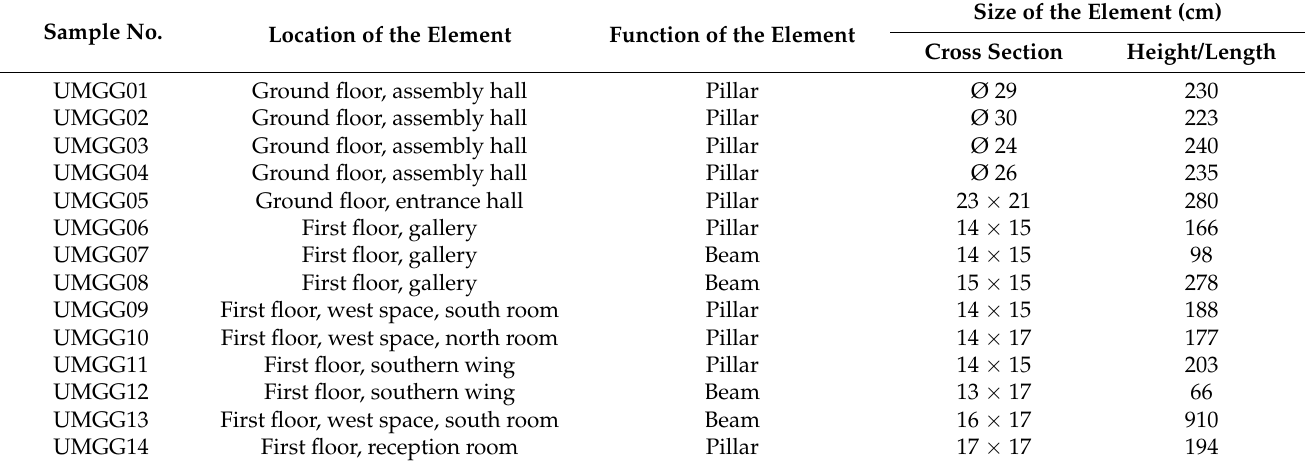
Table 1. Core samples collected in Gönpa Gang—basic information.